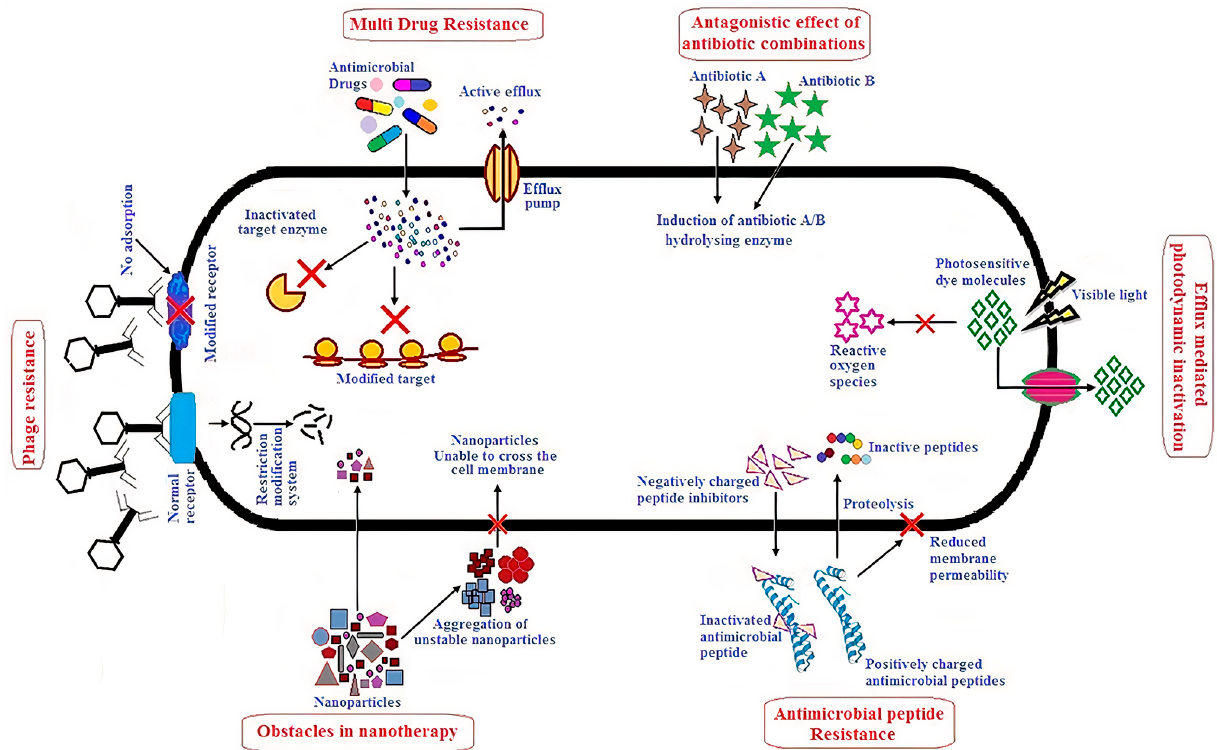
Figure 1. Alternative approaches to overcome multidrug − resistant (MDR) microbes and their possible shortcomings. Reprinted from [1].